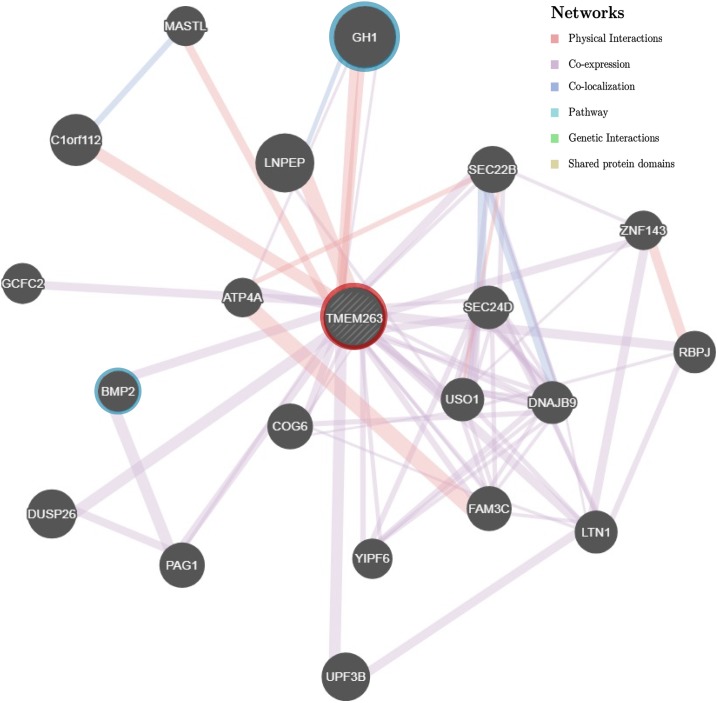
Gene association network of human TMEM263 gene. The gray dashed circle in the center with red ring represents TMEM263. The size of the solid circles representing other genes is proportional to the number of interactions they have. Gene GH1 and BMP2 are highlighted with blue rings to emphasize the two network branches. Red branch stands for physical interaction, purple branch displays co-expression, and blue branch means co-localization.